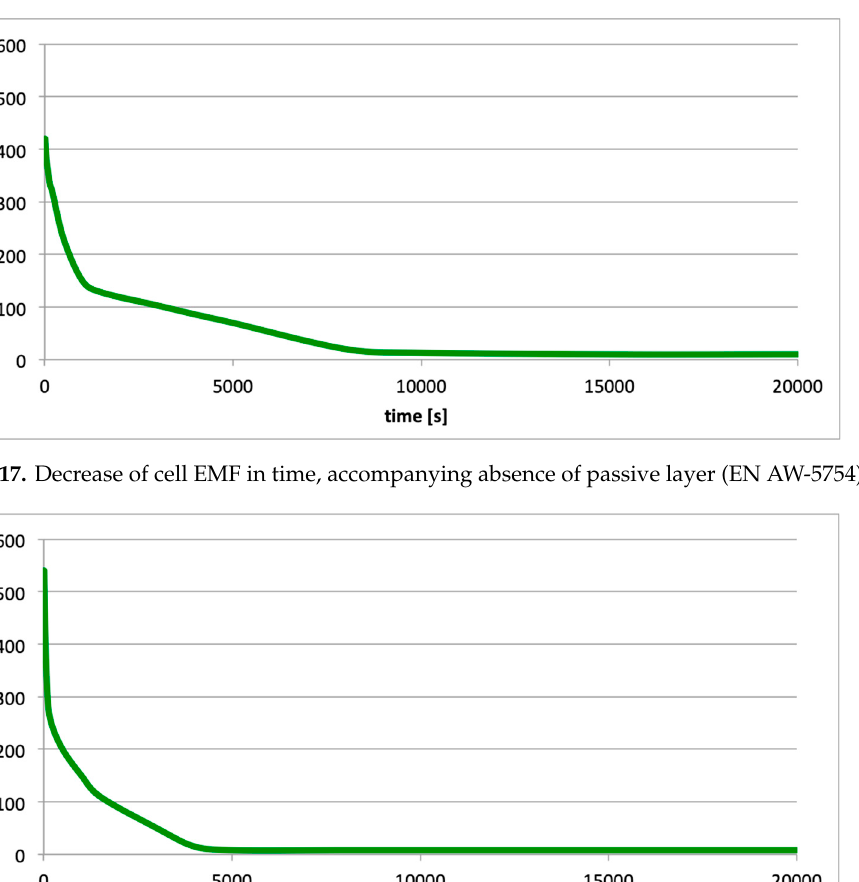
Figure 16. Decrease of cell EMF in time, accompanying absence of passive layer (EN AW-1050A).